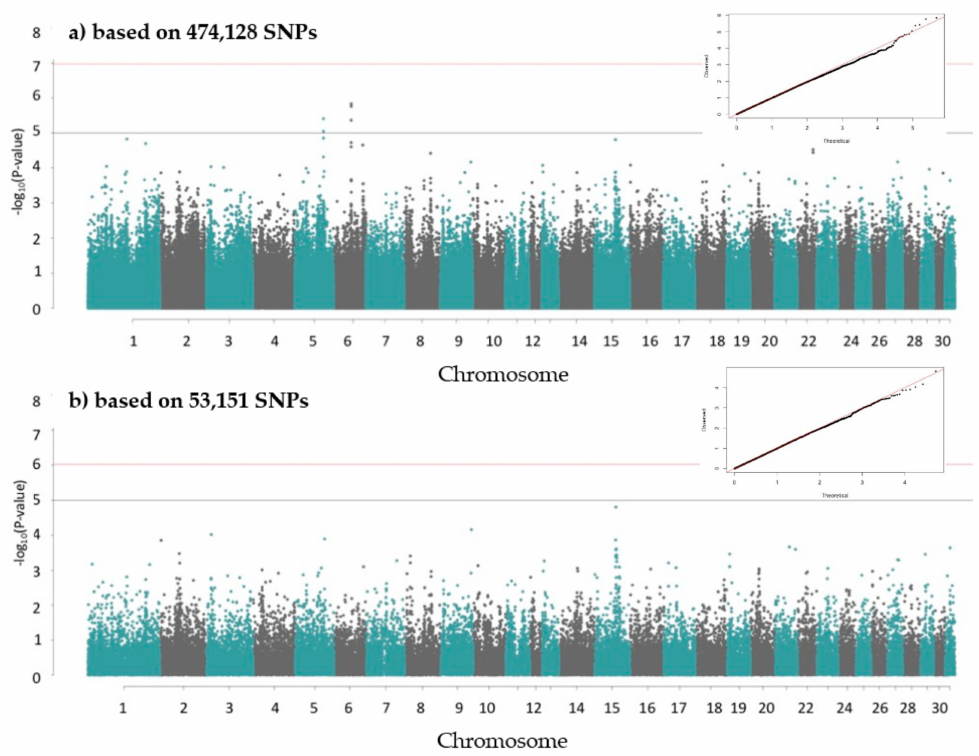
Figure A2. Manhattan plot with position on the genome on the x-axis and significance ( − log10( p -values)) on the y-axis in the Belgian Warmblood horse population for L_Culn7 using ( a ) all 474,128 SNPs after quality control, or ( b ) a subset of all SNPs representing the density used in the Shetland pony and Icelandic horse populations, being the overlap between the two SNP arrays that were used to genotype the individuals. The red line represents the Bonferonni corrected significance threshold and the black line a nominal significance threshold ( p -value = 1 × 10 − 5 ). Q-Q plots indicating that inflation factor lambda was < 1, requiring no further